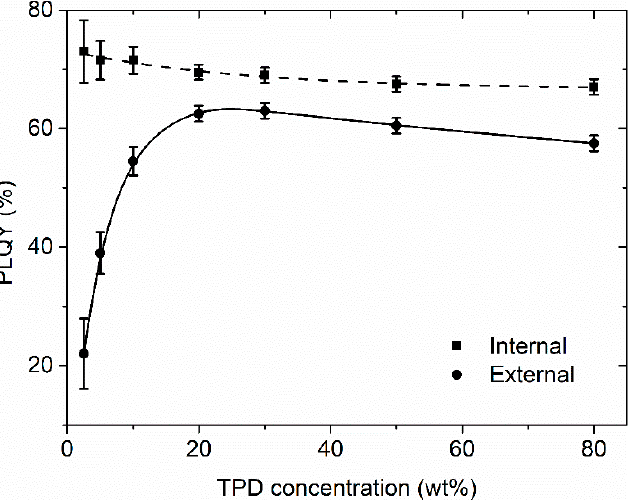
Figure 6. External PLQY (ratio between emitted and incident light) and internal PLQY (ratio between emitted and absorbed light) of active films of PS doped with different concentrations of TPD.